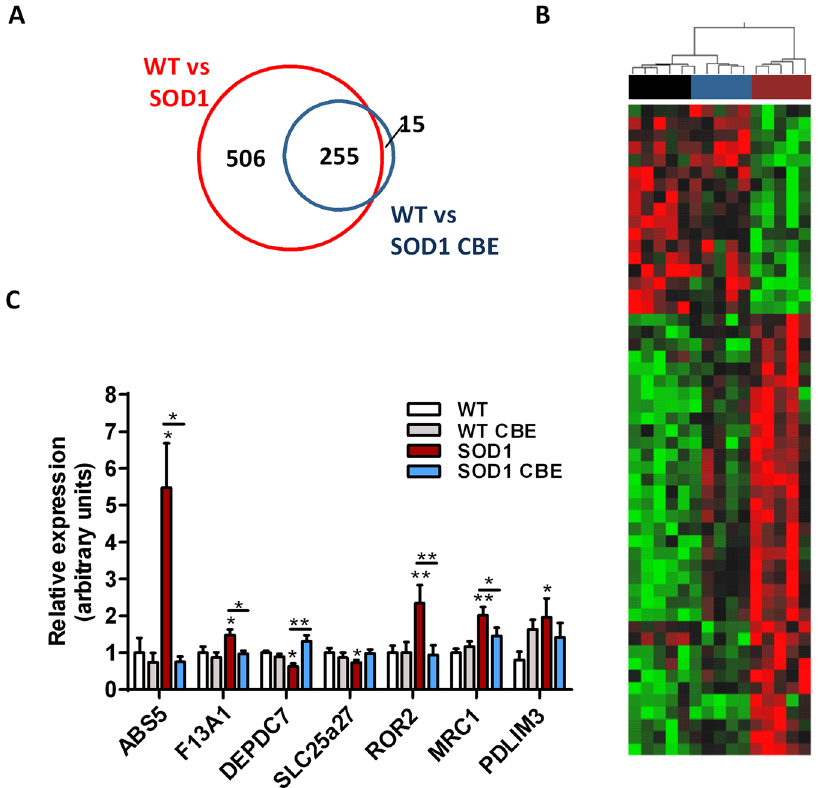
Figure 4. CBE treatment corrects transcriptomic dysregulation in spinal cord of SOD1 G86R mice. ( A ) Venn diagrams showing gene dysregulations in the spinal cord in SOD1 G86R mice receiving the vehicle (red circles) or the CBE (blue circles), and compared to wild type. ( B ) Hierarchical clustering performed with genes significantly regulated by CBE in SOD1 G86R mice in the spinal cord (black: wild type; blue: SOD1 G86R -CBE; dark red: SOD1 G86R veh). ( C ) Expression levels determined by quantitative PCR for selected genes. Data are presented as Mean + / − SEM; * p-value <